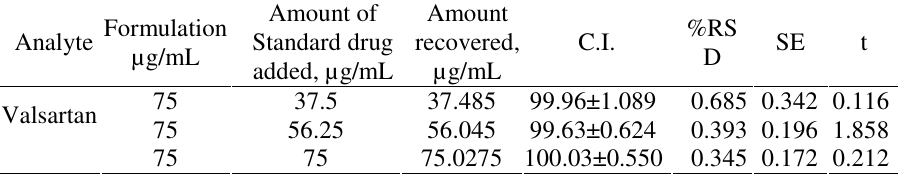
Table 4. Recovery studies of